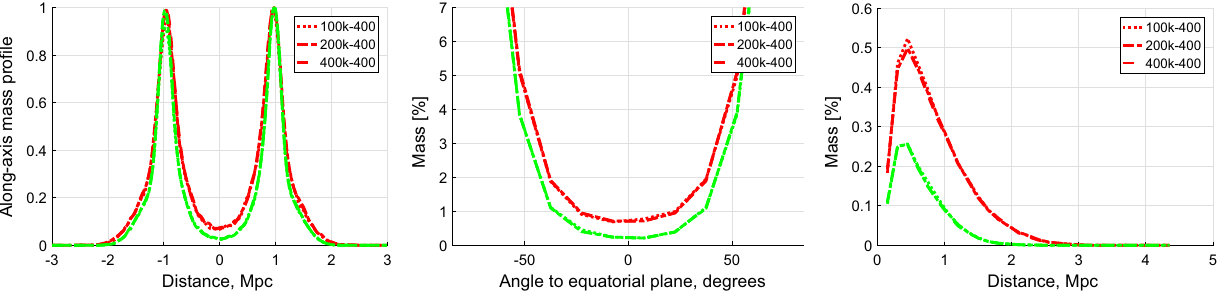
Fig. 14 The three SIDM-versus-CDM effects in axial ( left ), azimuthal ( center ), and radial ( right ) distribution of dark matter in a high-speed galaxy cluster collision inspected with respect to varying the number of particles in the simulation. Red lines are for SIDM and green lines